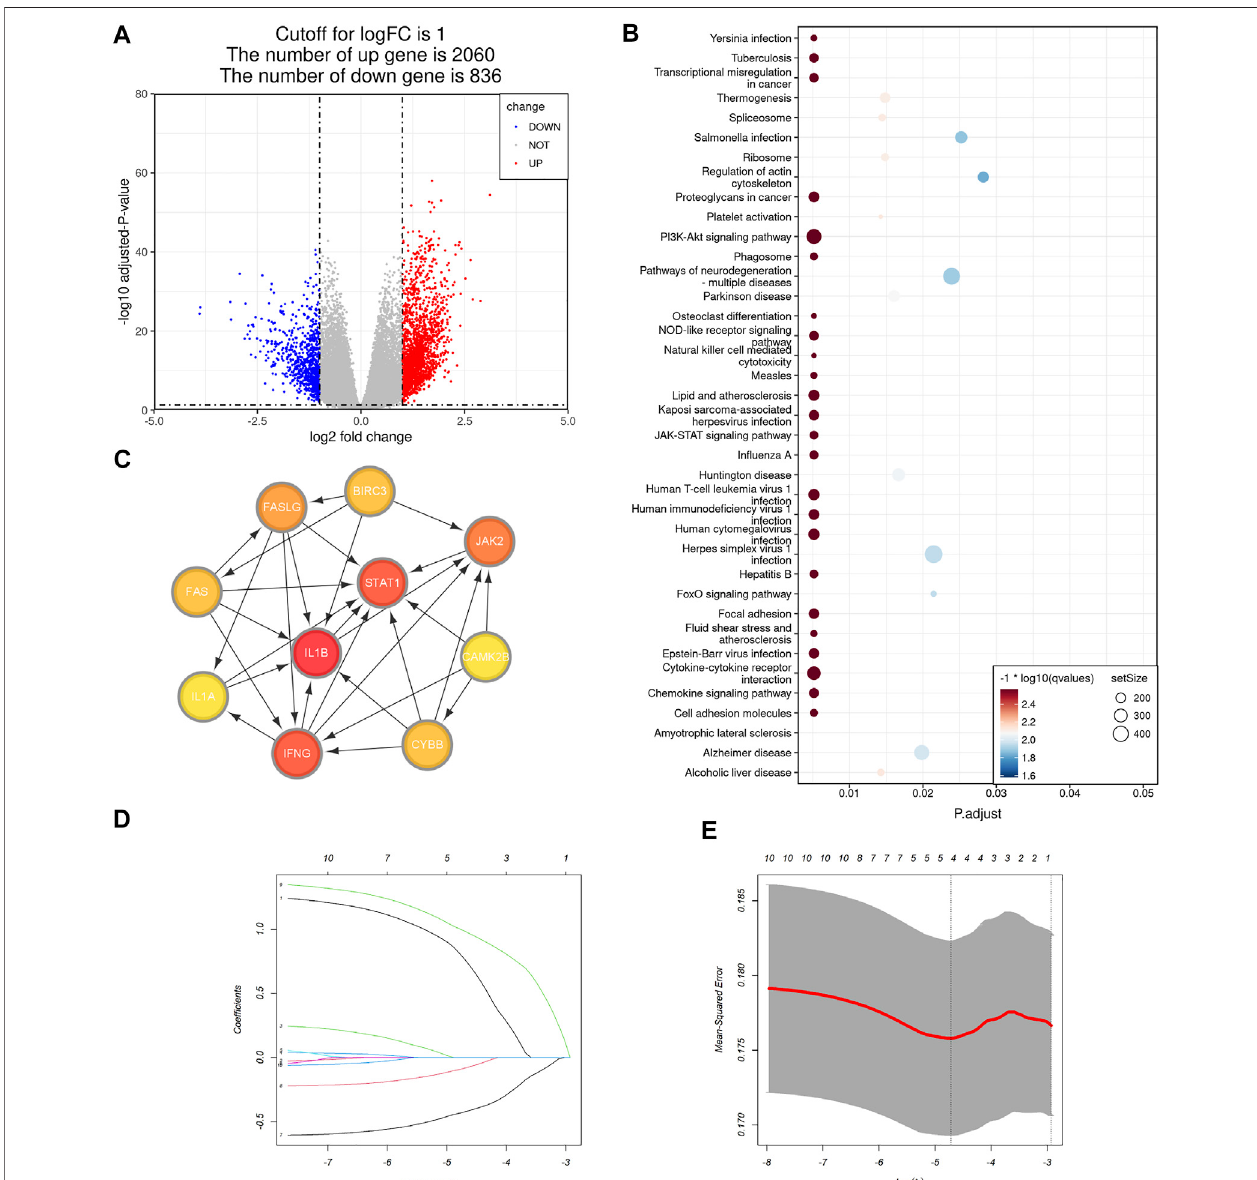
FIGURE 4 | Selection of the necroptosis gene signature in colon cancer. (A) Volcano plot of differentially expressed genes (DEGs) between the NRGs-activated group and NRGs-suppressed group. The red dots represent upregulated genes, while the blue dots represent downregulated genes [| log2 (fold change) | > 1 and adjusted p value < 0.05]. (B) BubbleplotofGSEApathwayenrichmentresultsoftheDEGsbetweentheNRGs-activatedgroupandNRGs-suppressedgroup.Sizeofthe circle represents the size of the gene set and color of the circle is based on -log10 (q value). (C) Protein-protein interaction (PPI) network including both functional and physical associations of hub necroptosis genes identi fi ed in Cytoscape. Color shade of the gene correlates with its score obtained by Degree method using the “ cytoHubba ” plugin. (D) The10-foldcross-validationforvariableselectionintheLASSOmodel. (E) TheLASSOcoef fi cientpro fi leofthefournecroptosissignaturegenes.